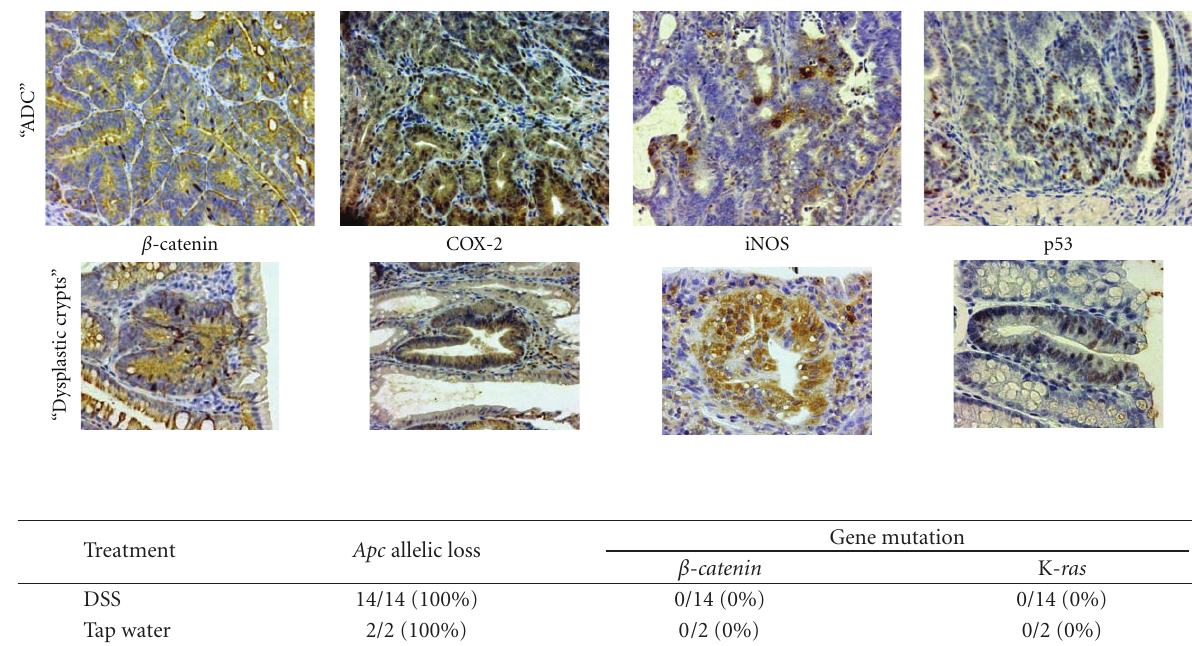
Figure 19: Immunohistochemistry of β -catenin, COX-2, iNOS, and p53 in the colonic adenocarcinoma and dysplastic crypts developed in male Apc Min/ + mice that received 2% DSS (upper panel). Apc allelic loss and gene mutations of β - catenin and K- ras in the colonic adenocarcinoma from male Apc Min/ + mice (lower